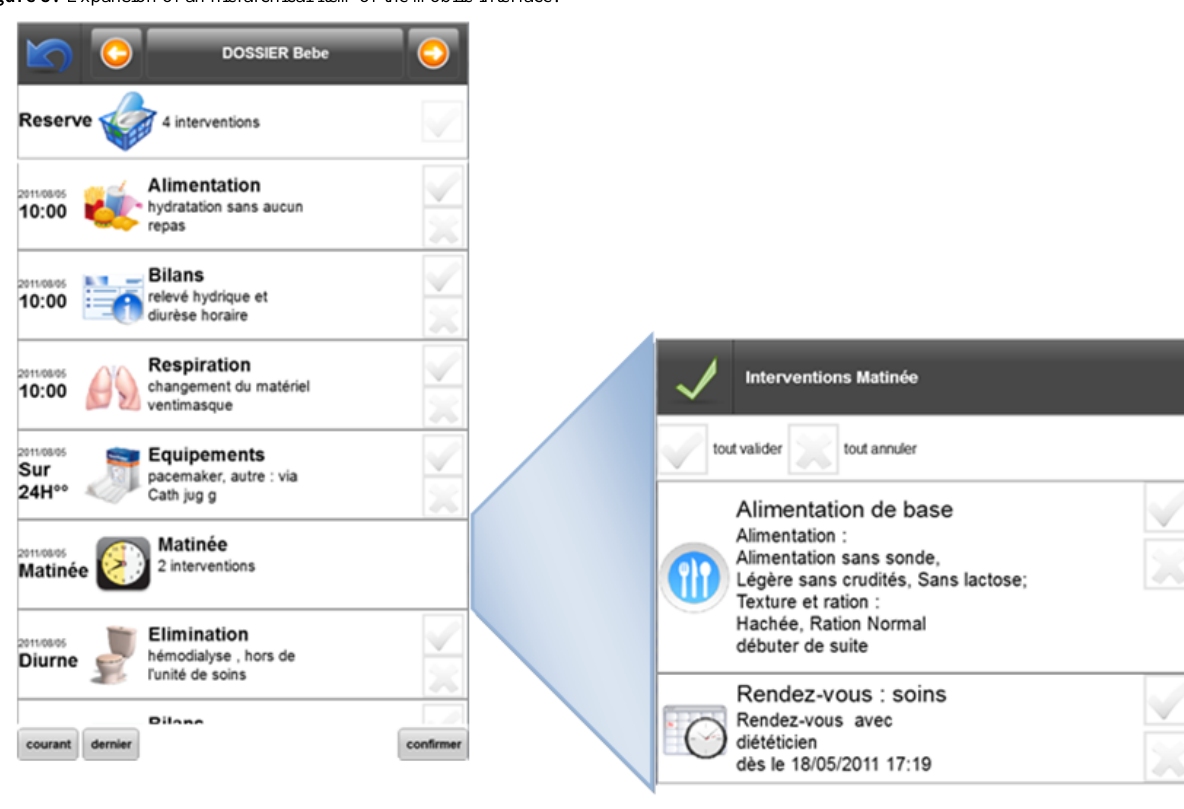
Figure 5. Expansion of an hierarchical item of the mobile interface.